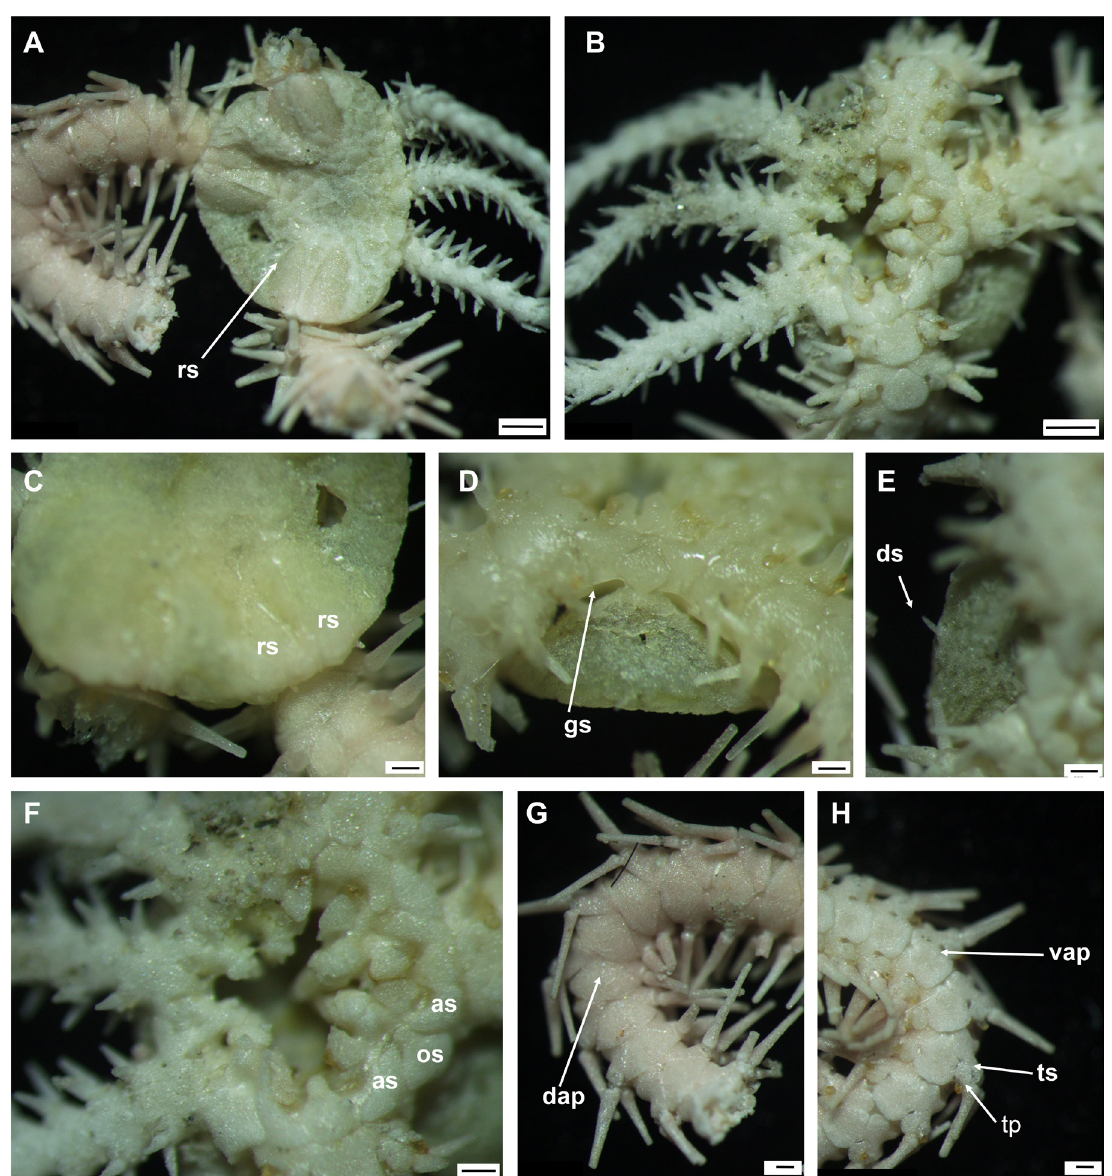
Fig. 42. Ophiactis cf. brachygenys H.L. Clark, 1911 (IDSSE EEB-SW0016 = hexamerous specimen). A . Dorsal disc. B . Ventral disc. C . Radial shields. D . Lateral disc. E . Disc spine. F . Oral frame. G . Dorsal arm. H . Ventral arm. Abbreviations: as = adoral shield; dap = dorsal arm plate; ds = disc spine; gs = genital slit; os = oral shield; rs = radial shield; tp = tentacle pore; ts = tentacle scale; vap = ventral arm plate. Scale bars: A–B = 500 µm; C–H = 200